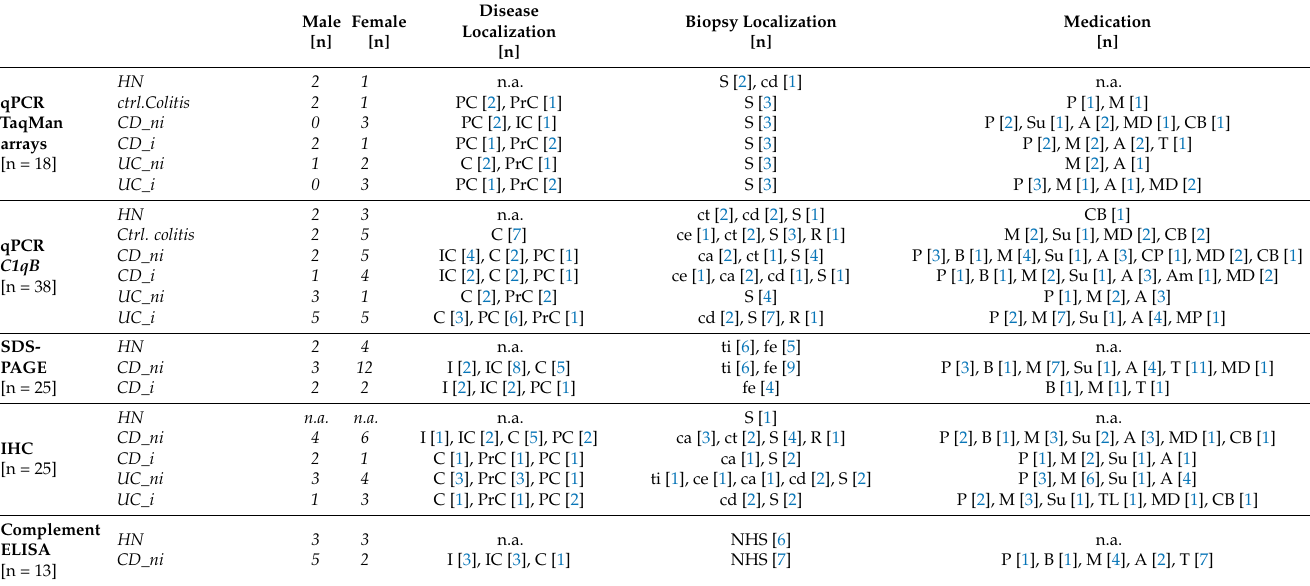
Table 1. Overview of study